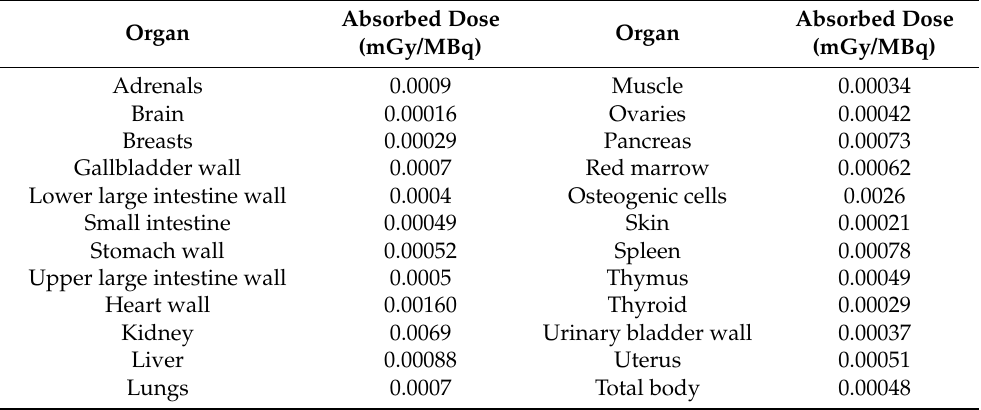
Table 5. Calculated absorbed dose (mGy/MBq) for [ 99m Tc]Tc-ZHER2:41071 in humans using OLINDA/EXM